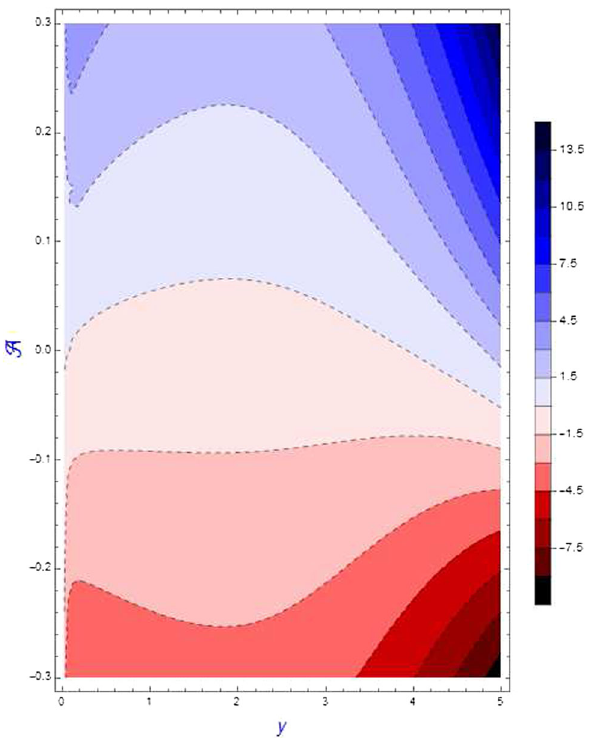
Fig. 6 The Toomre’s criterion (TC), Q − RHS versus the dimension- less radius y and the model parameter A for GNH3-M125 (for more details see the Table 1 of [60]). Here Γ = 2